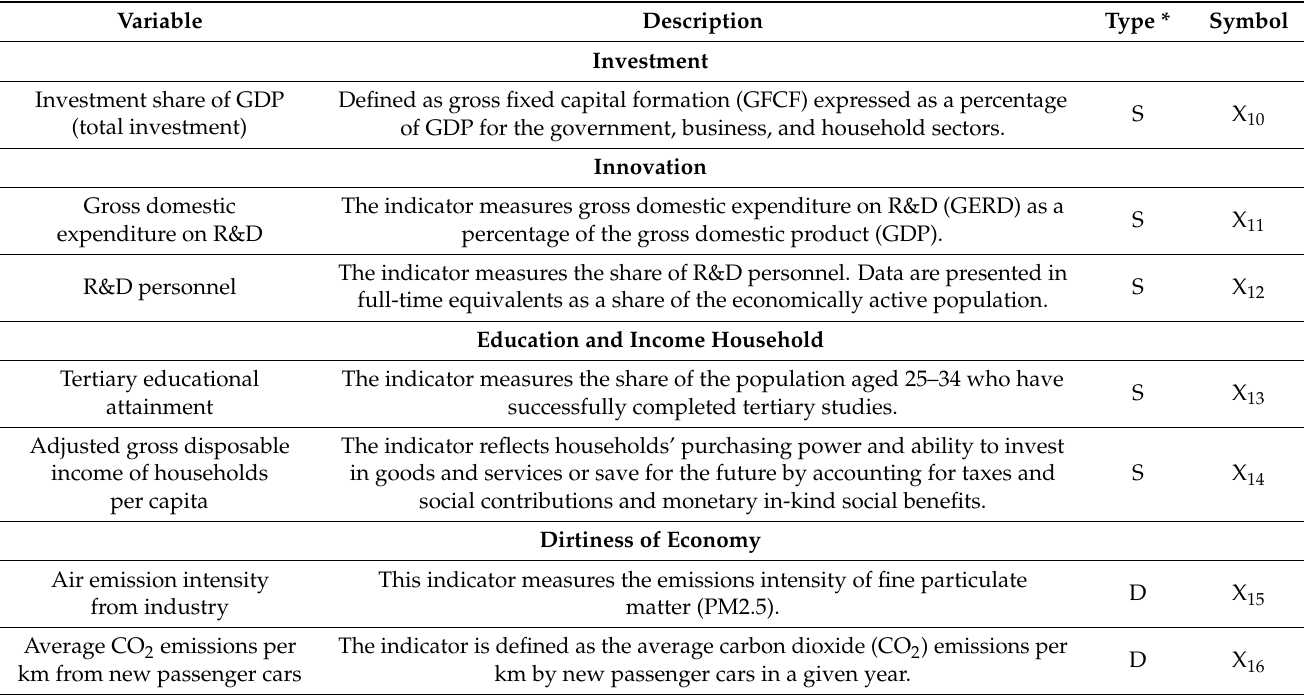
Table 2. Indicators related to the “macroeconomic heterogeneity” aspect of energy